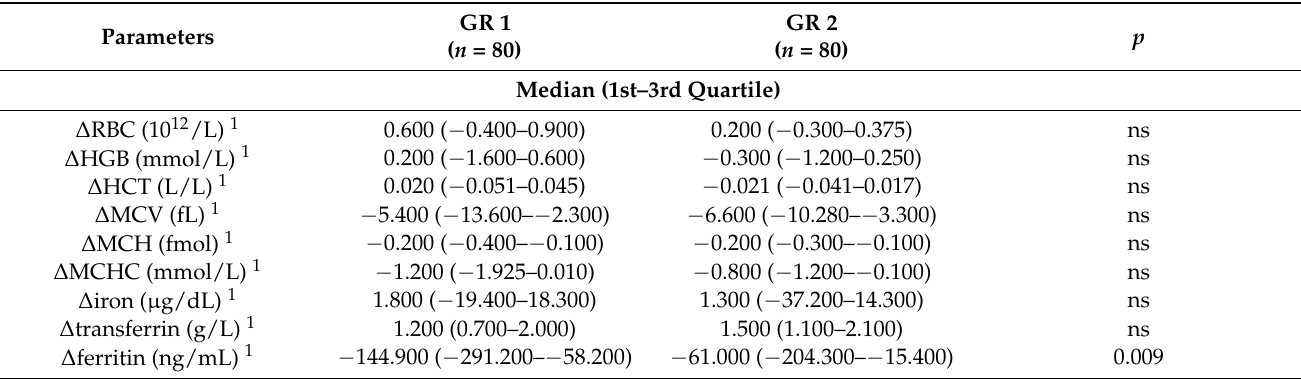
Table 5. Comparison of anaemia-related parameters between the study groups at the end of the trial-delta versus delta.